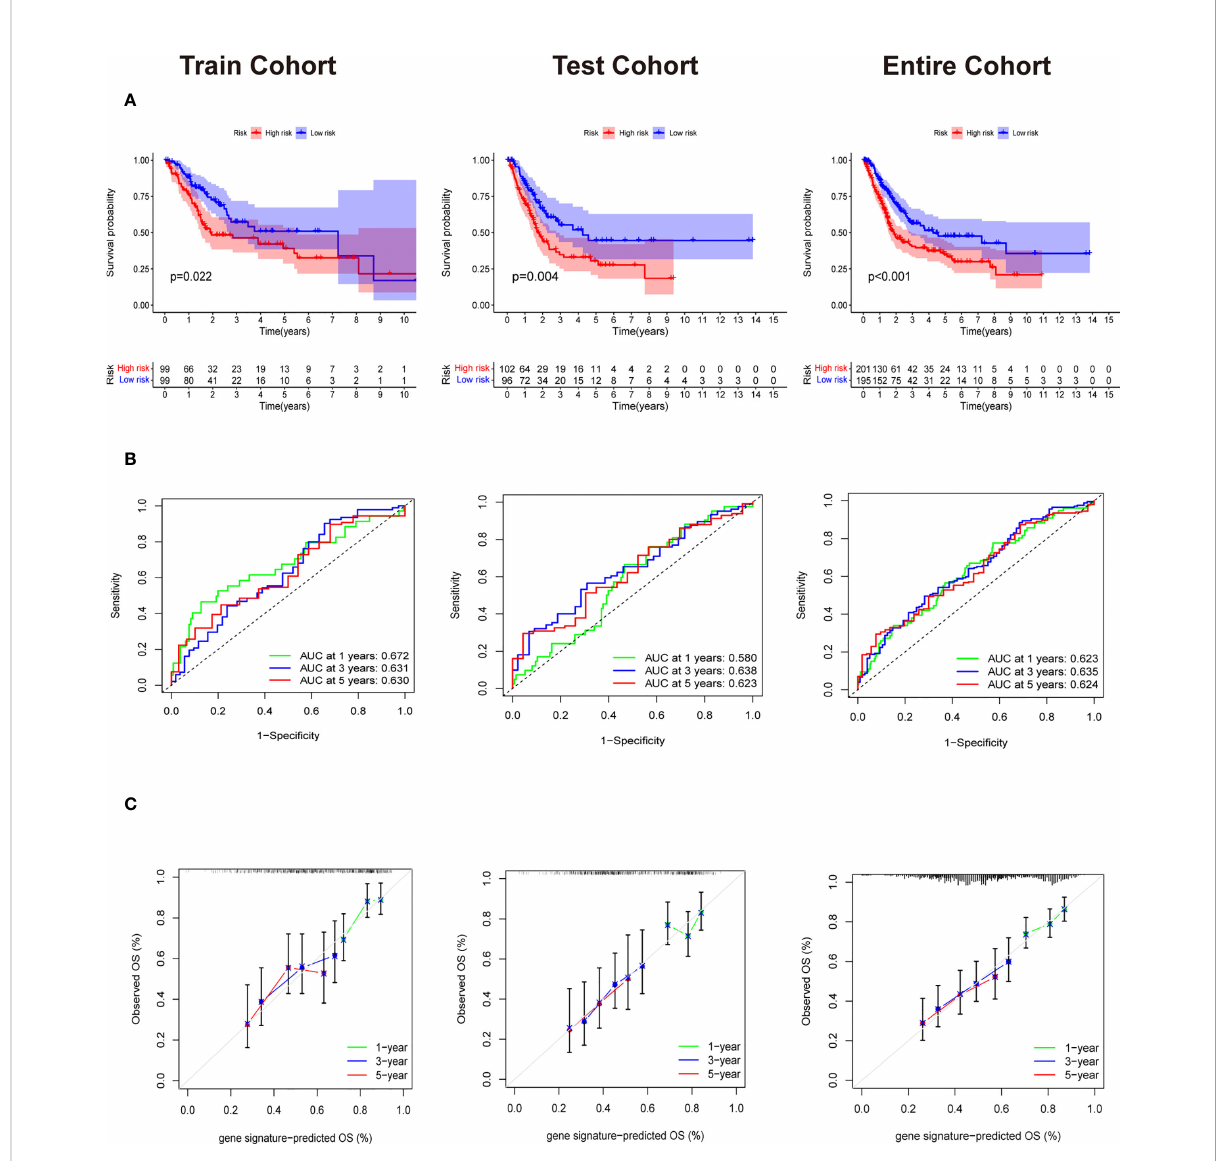
FIGURE 5 Validation of Evaluation of Six gene signature. (A) The Survival curve based on Kaplan Meier with log-rank test in train cohort,test cohort and entire cohort. (B) Time-dependent ROC curve means the accuracy of our model in predicting the 1 year, 3 year and 5 year survival rate. (C) Calibration curve that predicted 1 year, 3 year and 5 year survival